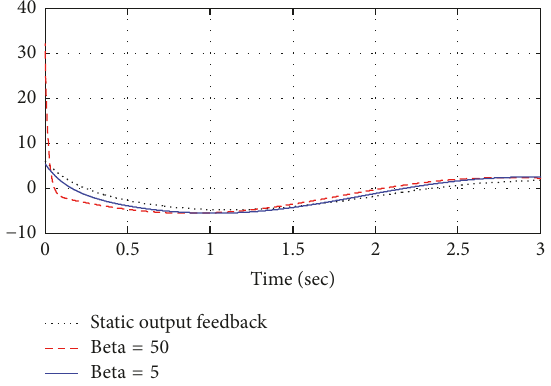
Figure 3: System input of the three